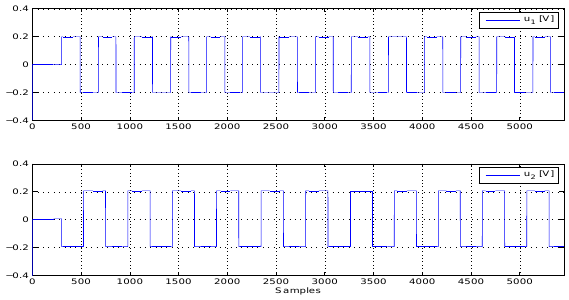
Figure 6: Open loop system identification input exper- iment, i.e. the volt input to the pumps.